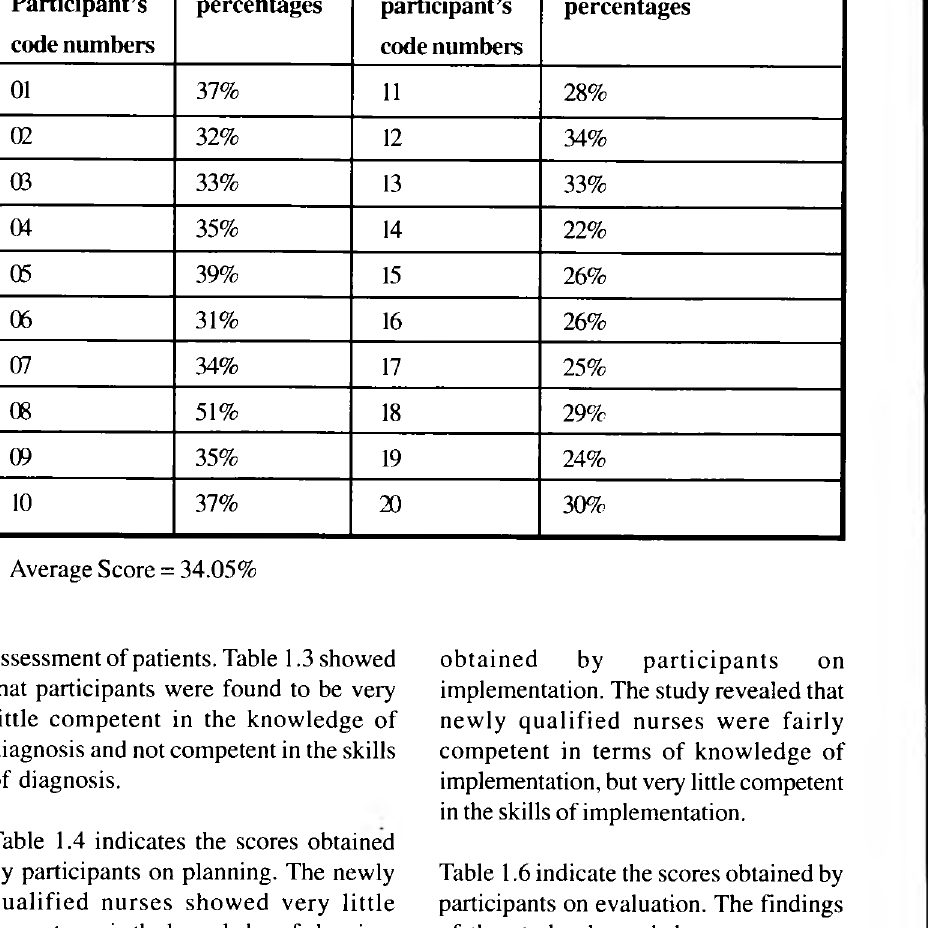
Table 1.1 Percentages obtained by participants in the evaluation phase.